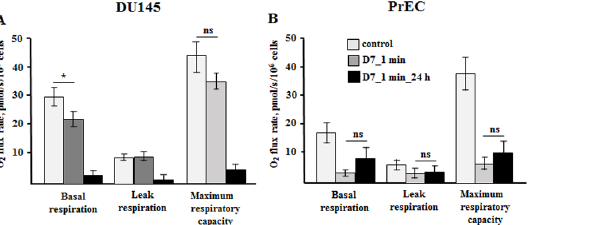
Fig 4. Respirometric analysis of non-thermal plasma effects on cell oxidative phosphorylation. Cells were measured in the respiratory buffer without respiratory substrates in order to evaluate the cell ’ s endogenous respiratory capacity. To evaluate the maximal respiratory activity the cells were inhibited with oligomycin to block ATP synthase and then titrated with increasing doses of protonophore. ( A,B ) Oxygen consumption rates in prostate cancer and normal cells immediately and after 24 hours post plasma treatment. Data presented as mean ± SEM (n = 4 – 6).